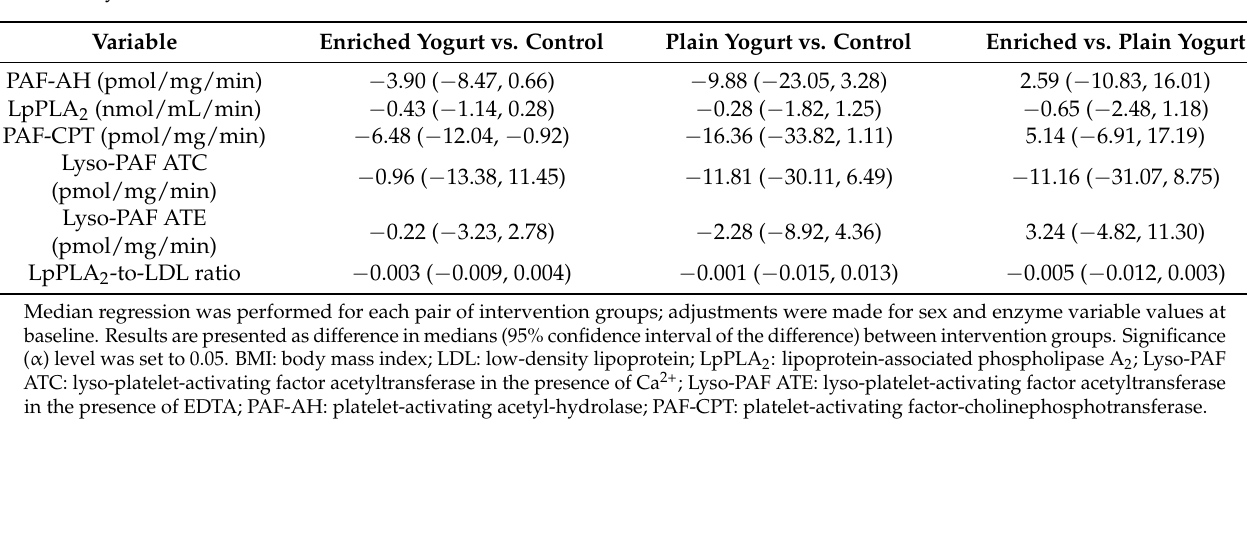
Table 4. Estimation of the difference in the enzyme activities between the intervention groups evaluated at week 4 of the